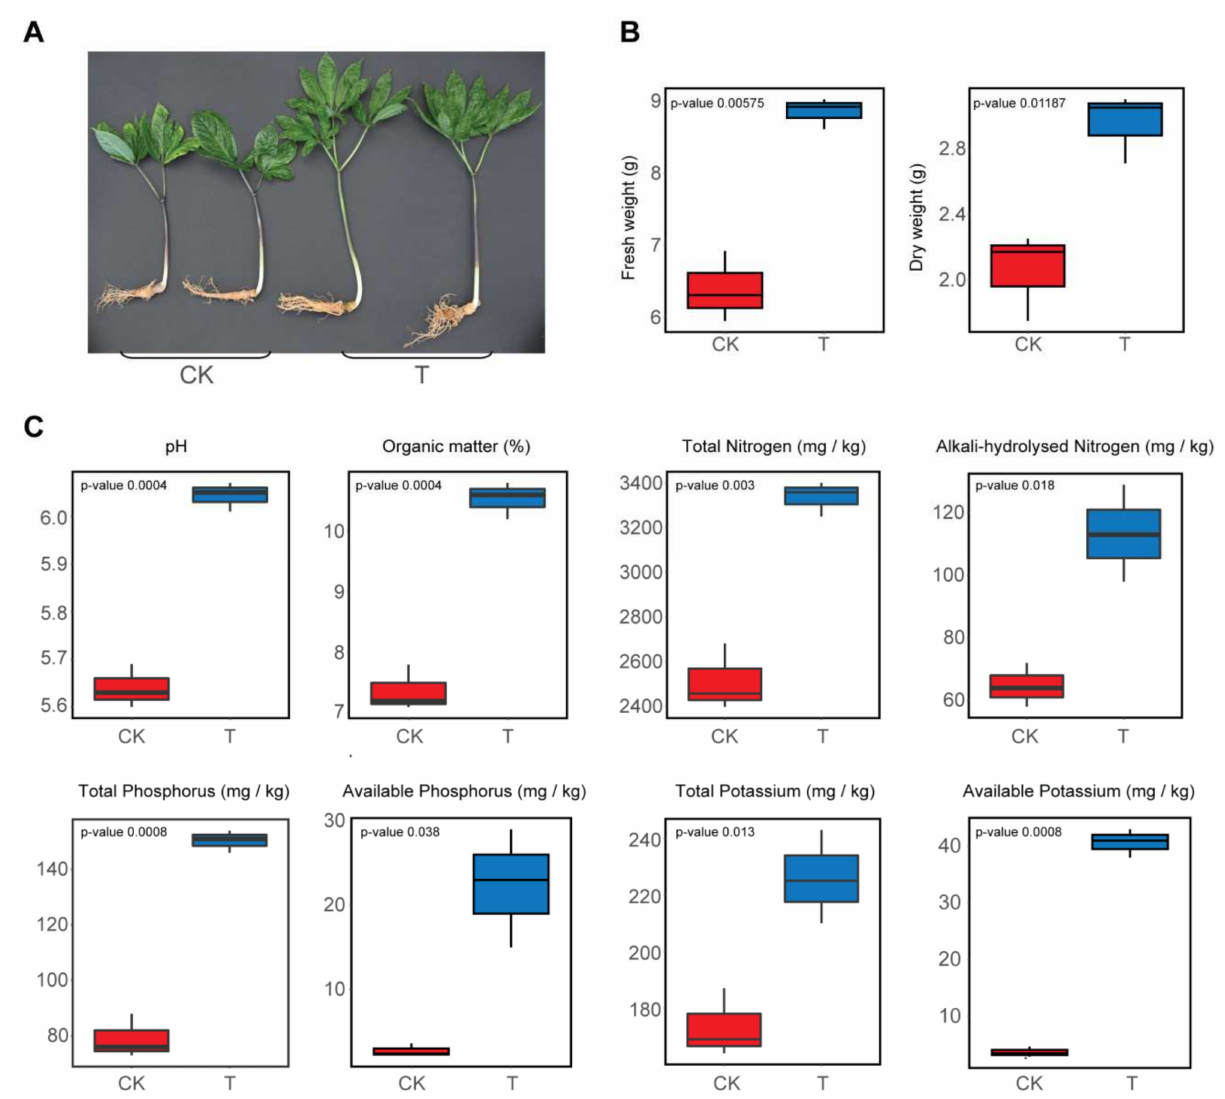
Figure 1. Effect of a bioorganic fertilizer application on P. notoginseng fresh and dry weights, root and shoot lengths, and soil physicochemical properties. ( A ) Representative images of P. notoginseng plants grown in soils without (CK) and with (T) a bioorganic fertilizer. ( B ) P. notoginseng plants fresh weight, dry weight, shoot length and root length. ( C ) Comparison of soil physicochemical properties between bioorganic fertilizer and non-fertilizer treatments. Whiskers in the red and blue box represent the range of minimum and maximum values within a control and bioorganic fertilizer treatment,